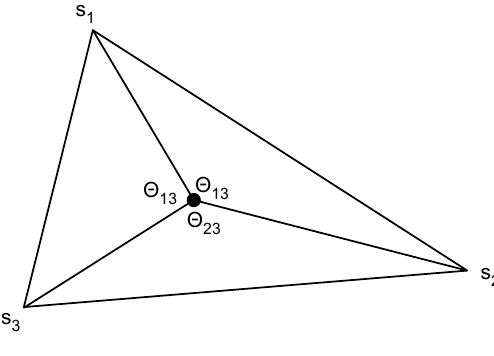
Figure 3. Triangulation method